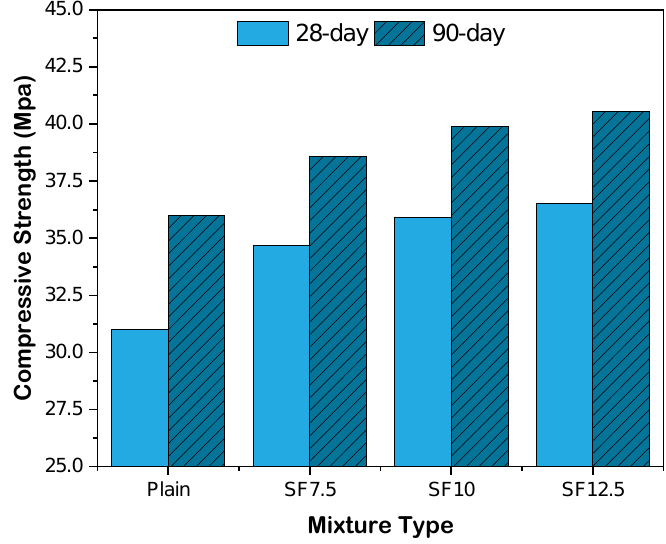
Figure 5. Compressive strength of concrete with Silica Fume.